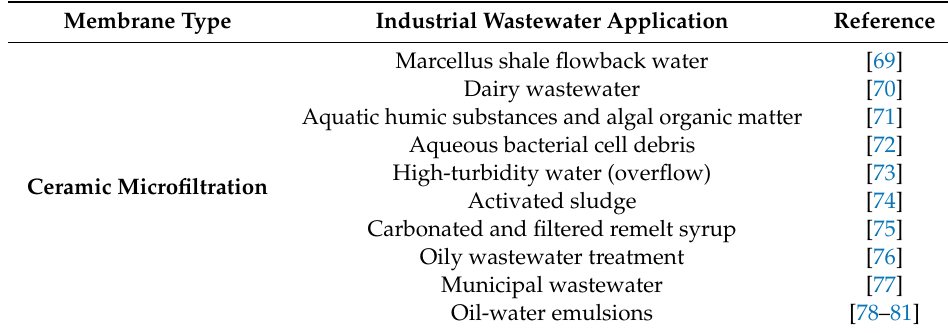
Table 2. MF industrial wastewater